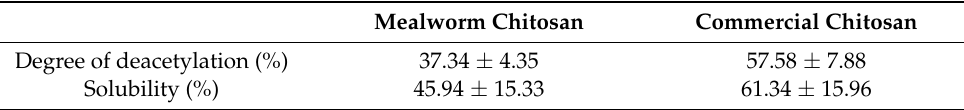
Table 3. Degree of deacetylation (%) and solubility (%) of chitosan extracted from mealworm when compared to commercial